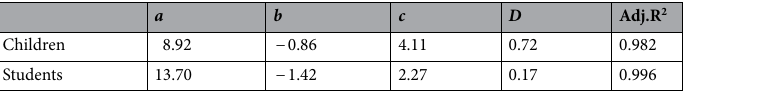
Table 9. Fitting results of the relation between relaxation time and initial speed of children and